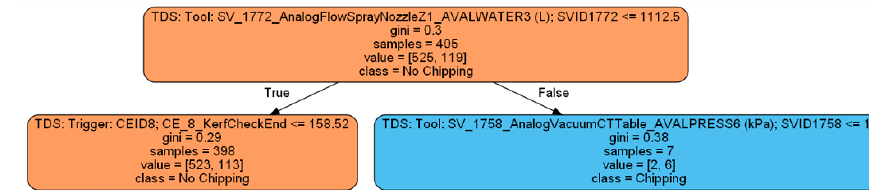
Figure 12. Condition of a node in the decision tree.